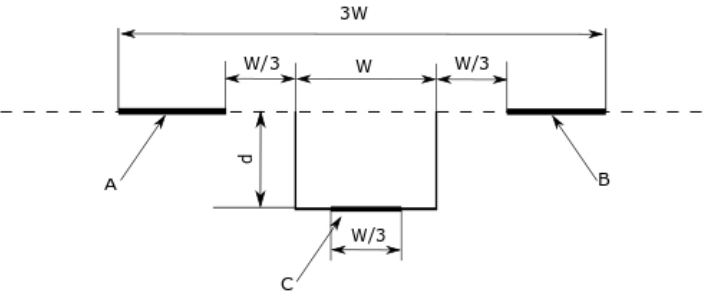
Figure 6. Typical schematic view for calculation of the groove’s depth according to the ISO 5436- 1:2000 standard; W —the width of the groove, d —the depth of the groove, C —the line segment in the middle of the groove, A and B —the line segments on the surface of the standard. (a) Interferometer